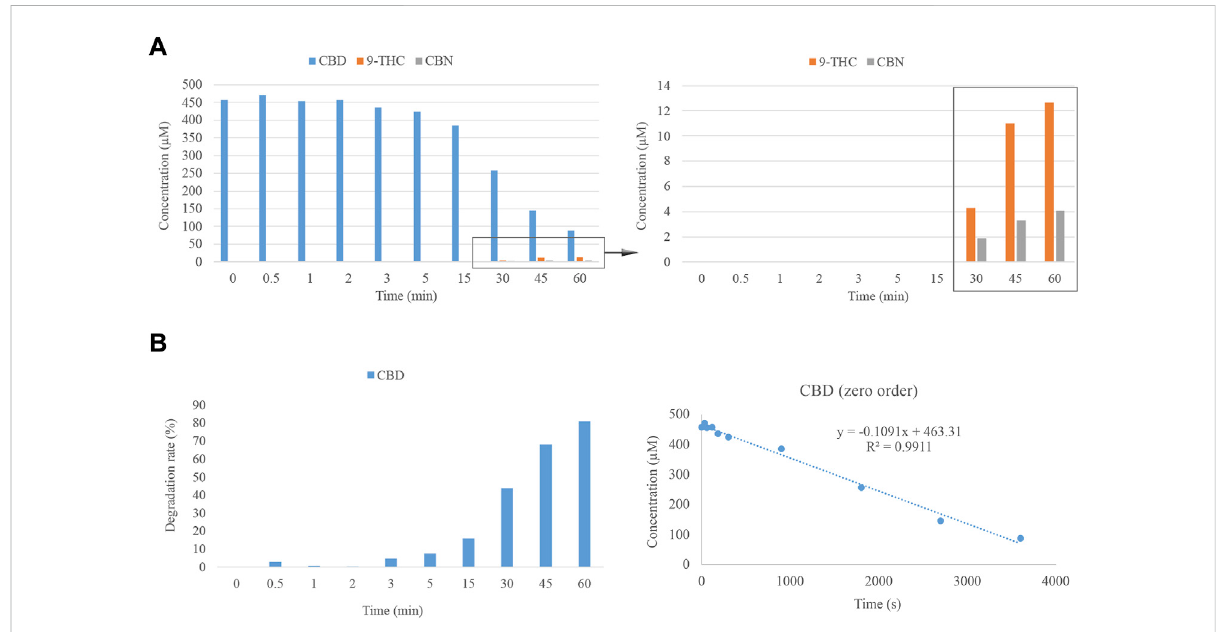
FIGURE 3 (A) Degradation of CBD considering the effect of time. (B) Degradation rate of CBD across the time interval under consideration at 220 ° C and zero-order plot for the degradation of CBD as a function of heating